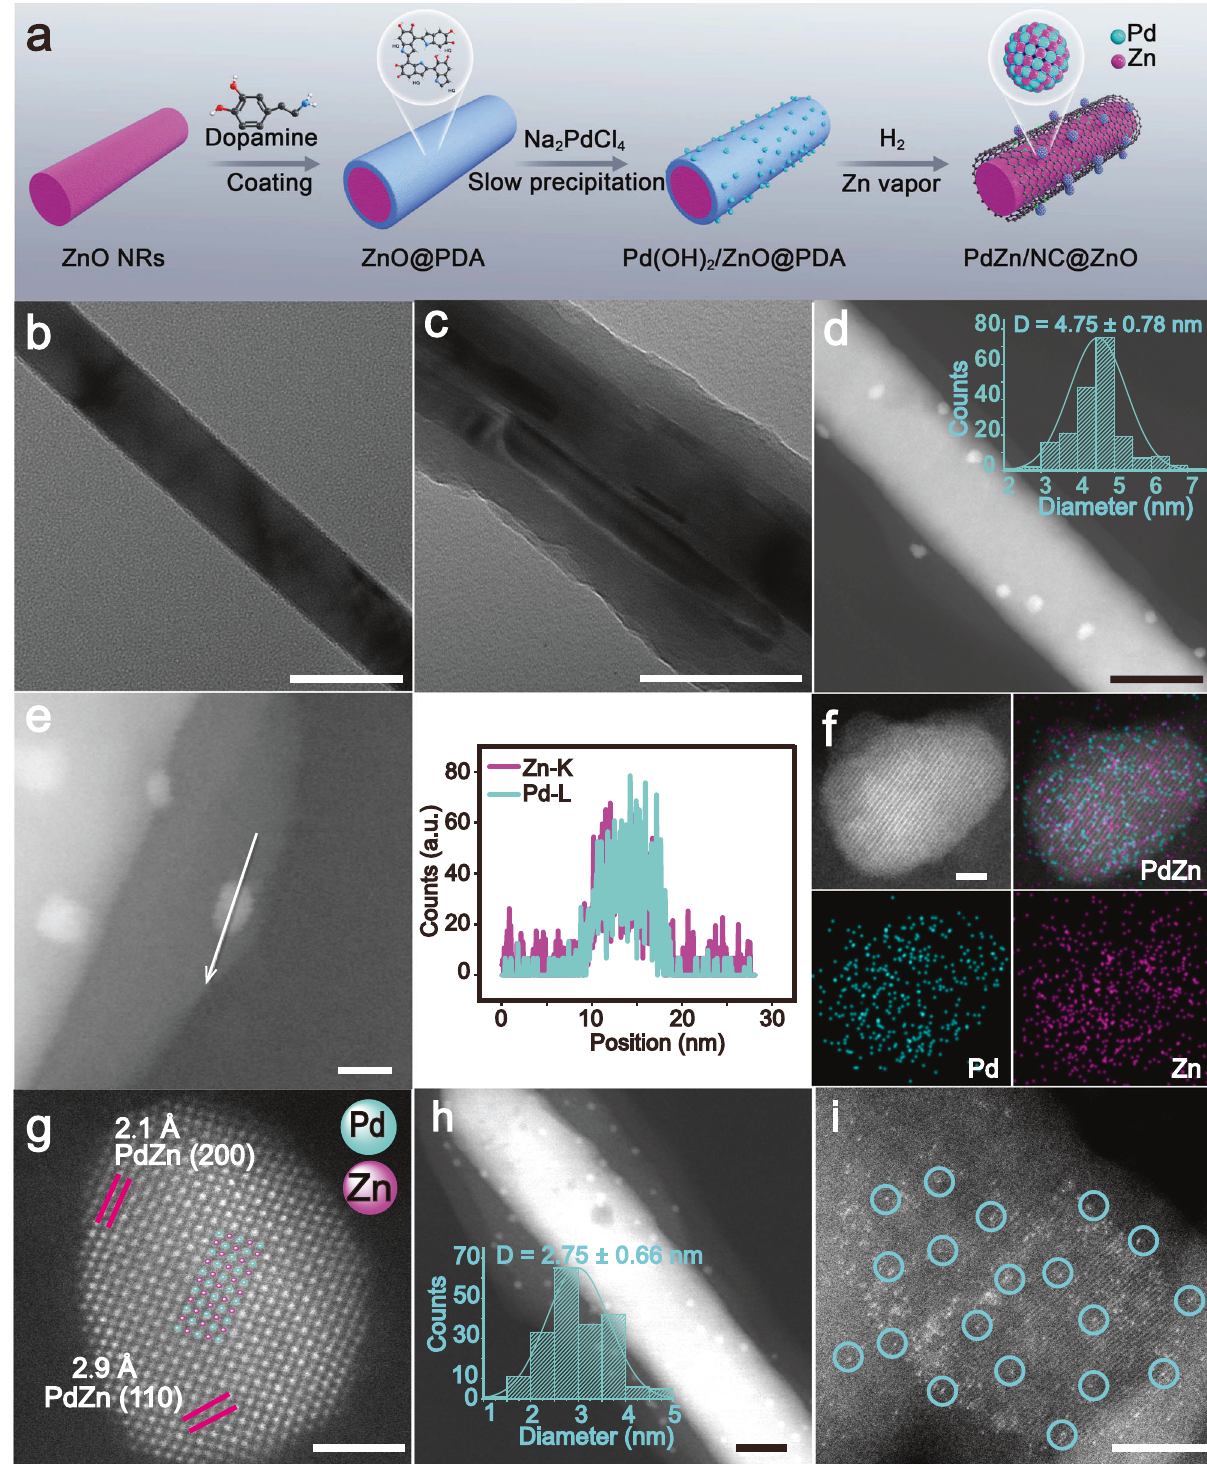
Fig. 1 Synthetic scheme and characterizations of synthesized catalysts. a Synthetic strategy of PdZn/NC@ZnO. b TEM image of ZnO nanorods. Scale bar, 50 nm. c TEM image of ZnO@PDA. Scale bar, 100 nm. d STEM image of PdZn/NC@ZnO, the inset is the size distribution histogram of